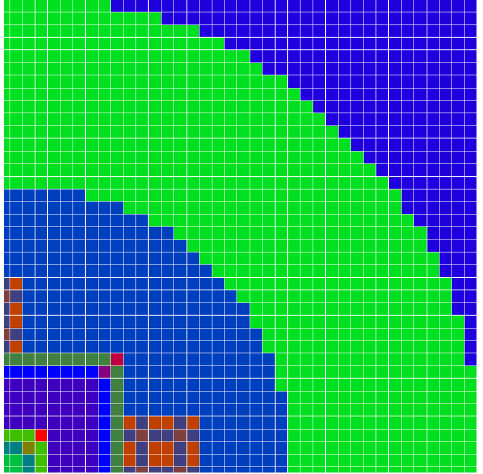
Figure 2: MINARET 2D